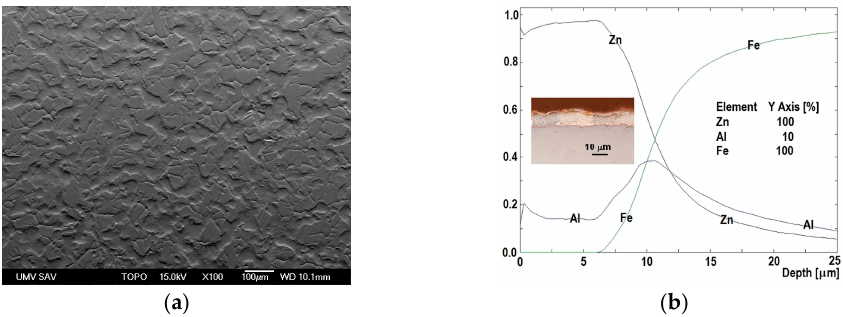
Figure 5. ( a ) Stochastic morphology of the surface of hot-dip galvanized sheet H22PD + Z100MBO and ( b ) GD-OES analysis of hot-dip galvanized coating.